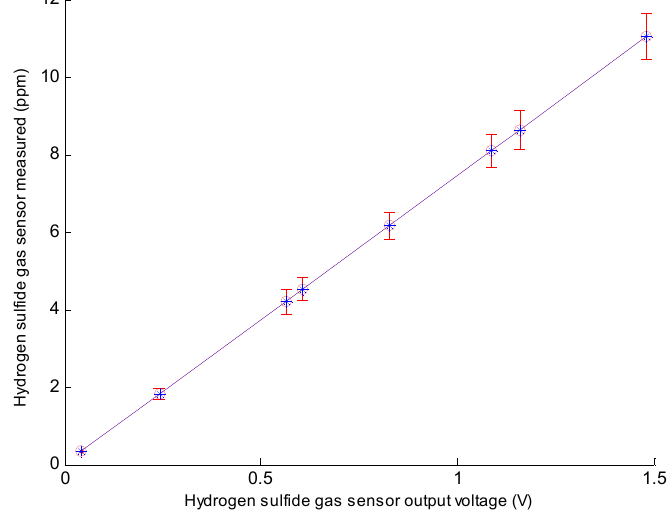
Figure 3. Hydrogen Sulfide Gas Sensor Calibration Curve.